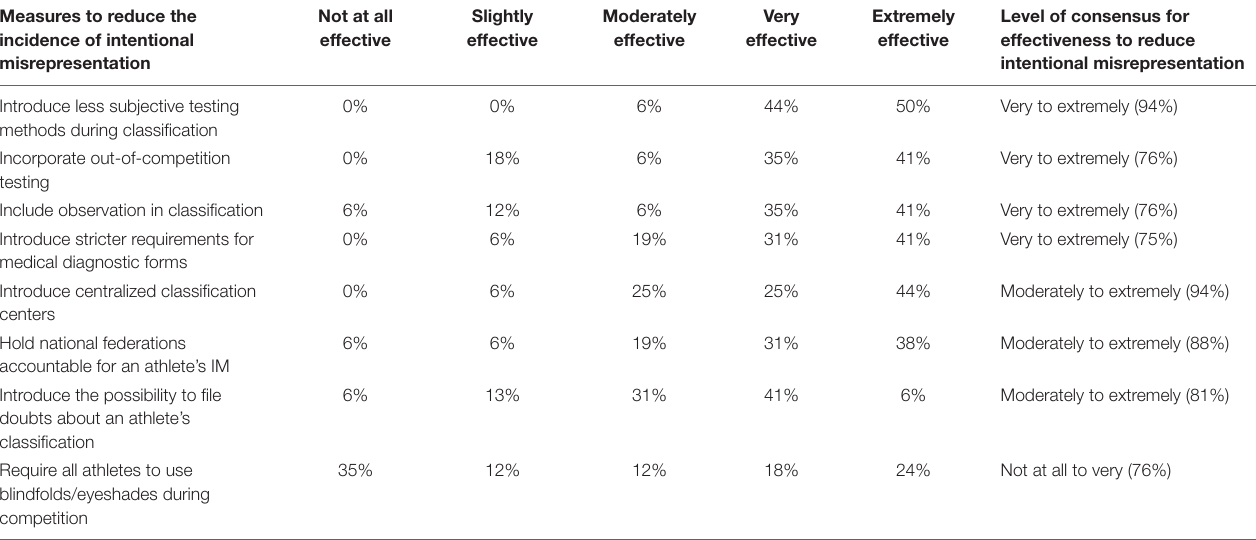
TABLE 6 | Relative effectiveness of measures to reduce the incidence of intentional misrepresentation in VI